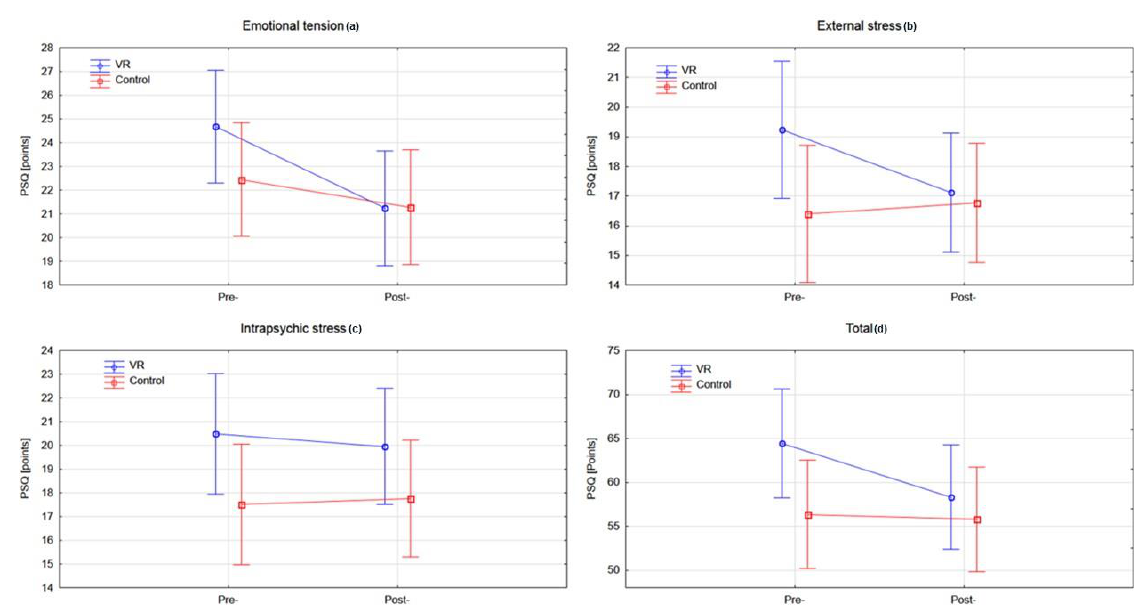
Figure 4. Analysis of the PSQ questionnaire in both groups pre- and post-rehabilitation program: ( a ) emotional tension ( b ) external stress ( c ) intrapsychic stress ( d ) total score. VR: virtual reality; PSQ: Perception of Stress Questionnaire